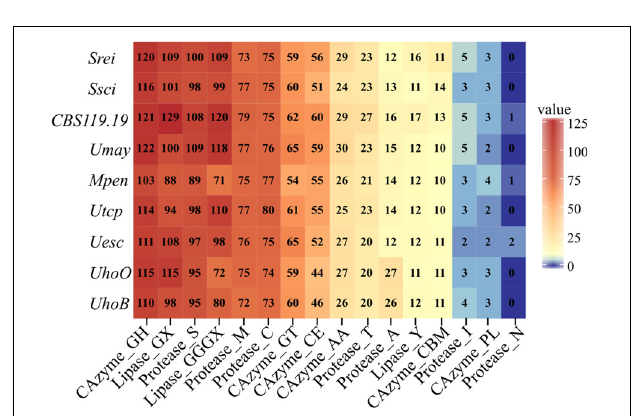
FIGURE 4 | Heatmap of CAZymes, proteases and lipases classes. The numbers of enzyme categories in each genome are shown. Classes and modules of CAZymes include: GHs ,glycoside hydrolases; CEs, carbohydrate esterases; CBMs, carbohydrate-binding modules; GTs, glycosyl transferases; PLs, polysaccharide lyases; AAs, auxiliary activities). Proteases are classified by the catalytic type of the proteolytic enzymes: A, aspartic; C, Cysteine; M, metallo; N, asparagine; S, serine; T, threonine; and also inhibitors of peptidases (I). Lipases are classified into three classes on the basis of the oxyanion hole: GX, GGGX, and Y. The scientific names were abbreviated according to Table 1 .